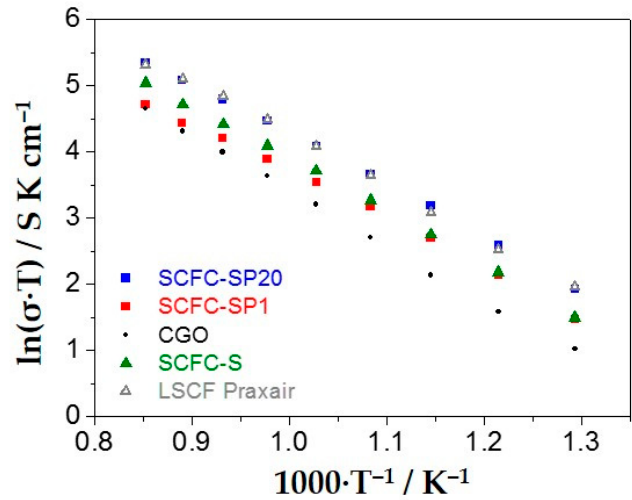
Figure 8. Electrical conductivity (Arrhenius plots) of the three samples under study in comparison with a reference LSCF Praxair perovskite.